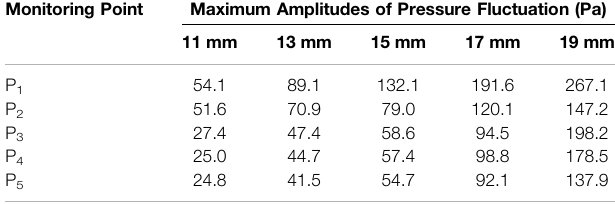
TABLE 2 | Pressure pulsation at inlet side.